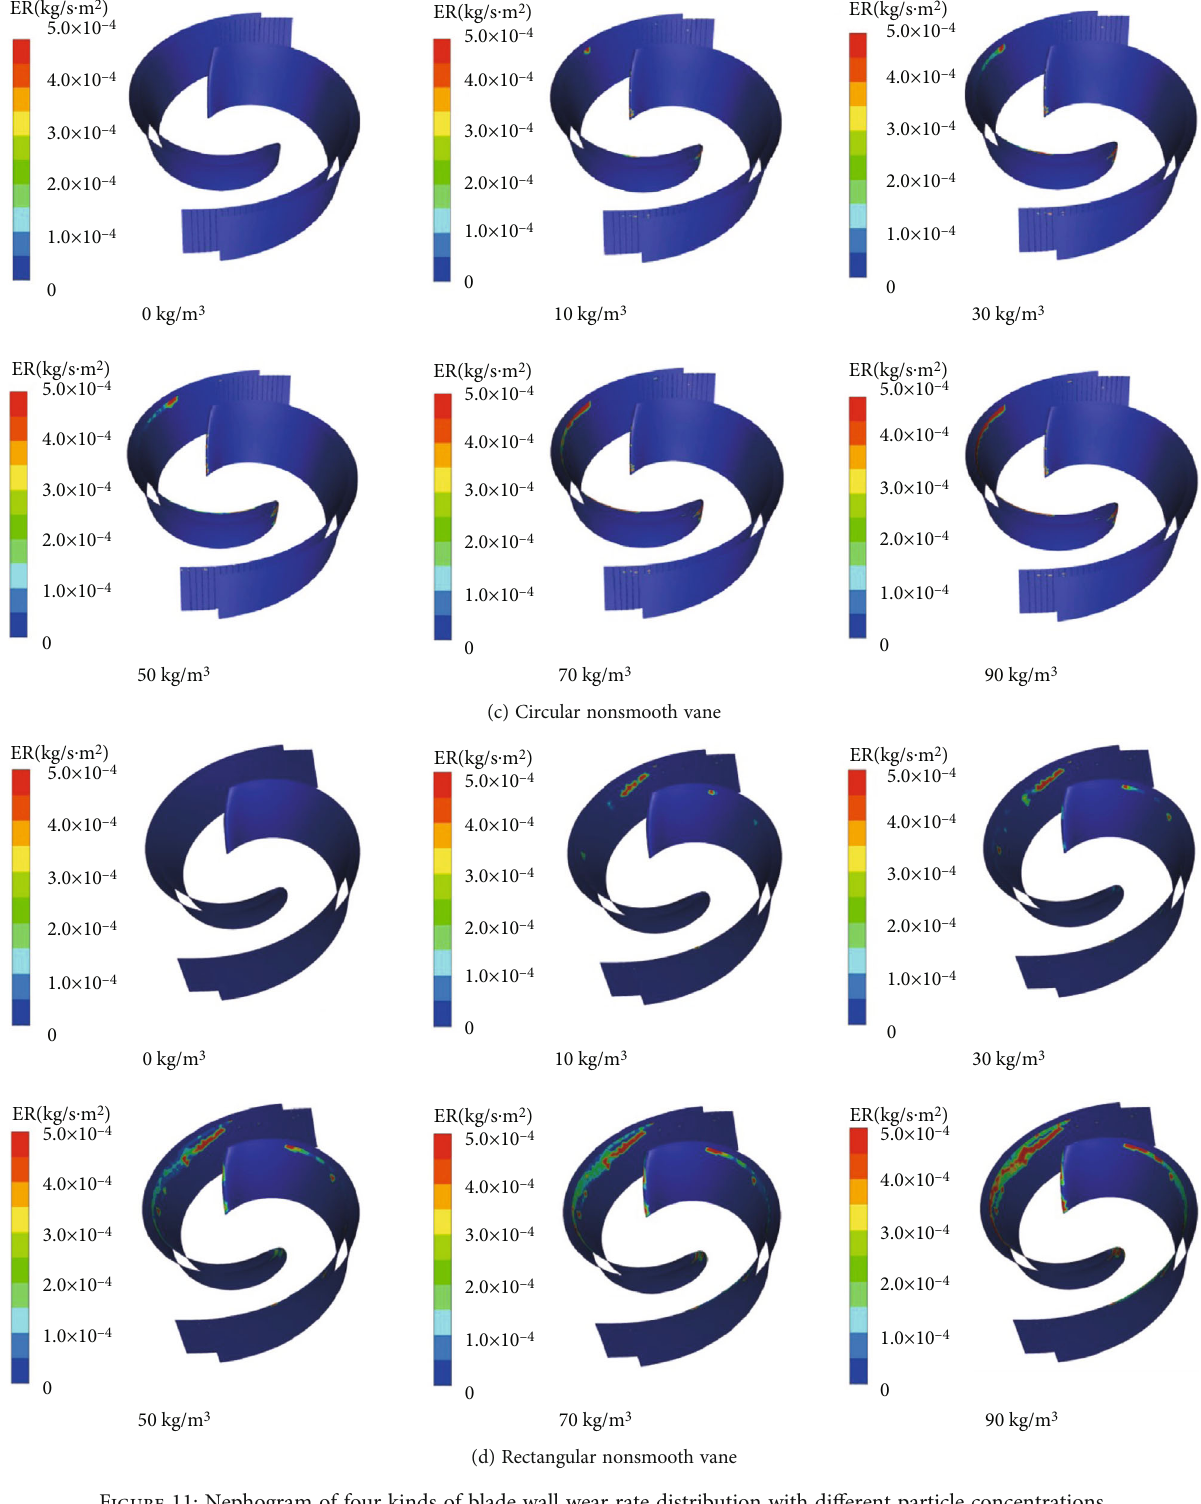
Figure 11: Nephogram of four kinds of blade wall wear rate distribution with di ff erent particle